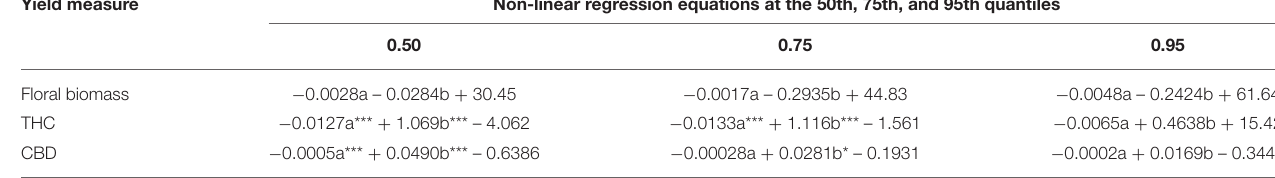
TABLE 3 | Non-linear (quadratic) quantile regression of the timing of photoperiod switches with floral biomass ( n = 29), THC concentration ( n = 50), and CBD concentration ( n = 31). Yield measure Non-linear regression equations at the 50th, 75th, and 95th